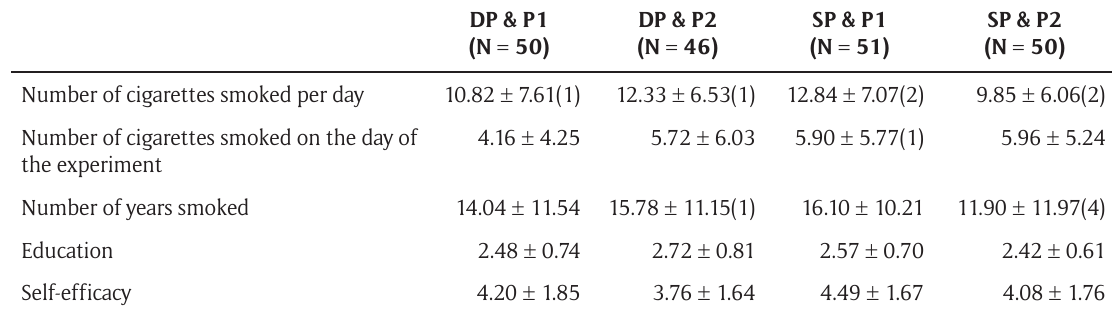
Table 3: Mean scores and standard deviations on secondary variables of Study